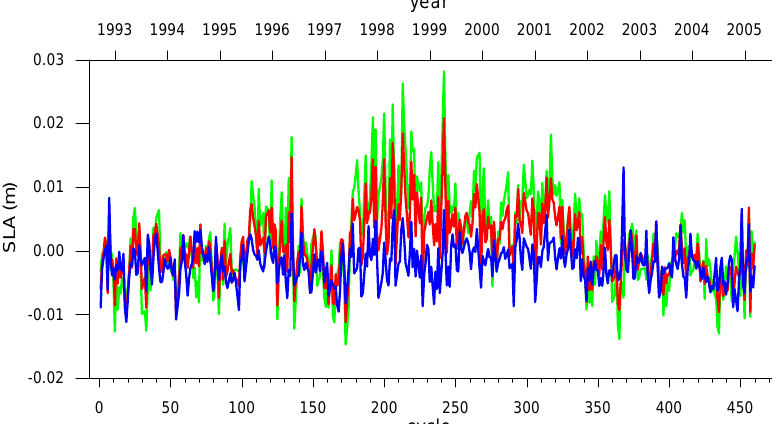
Figure 9. SLA differences DataSet1-DataSet7 (different orbits) blue - Tropical; red : Sub-Tropical; green: Sub-